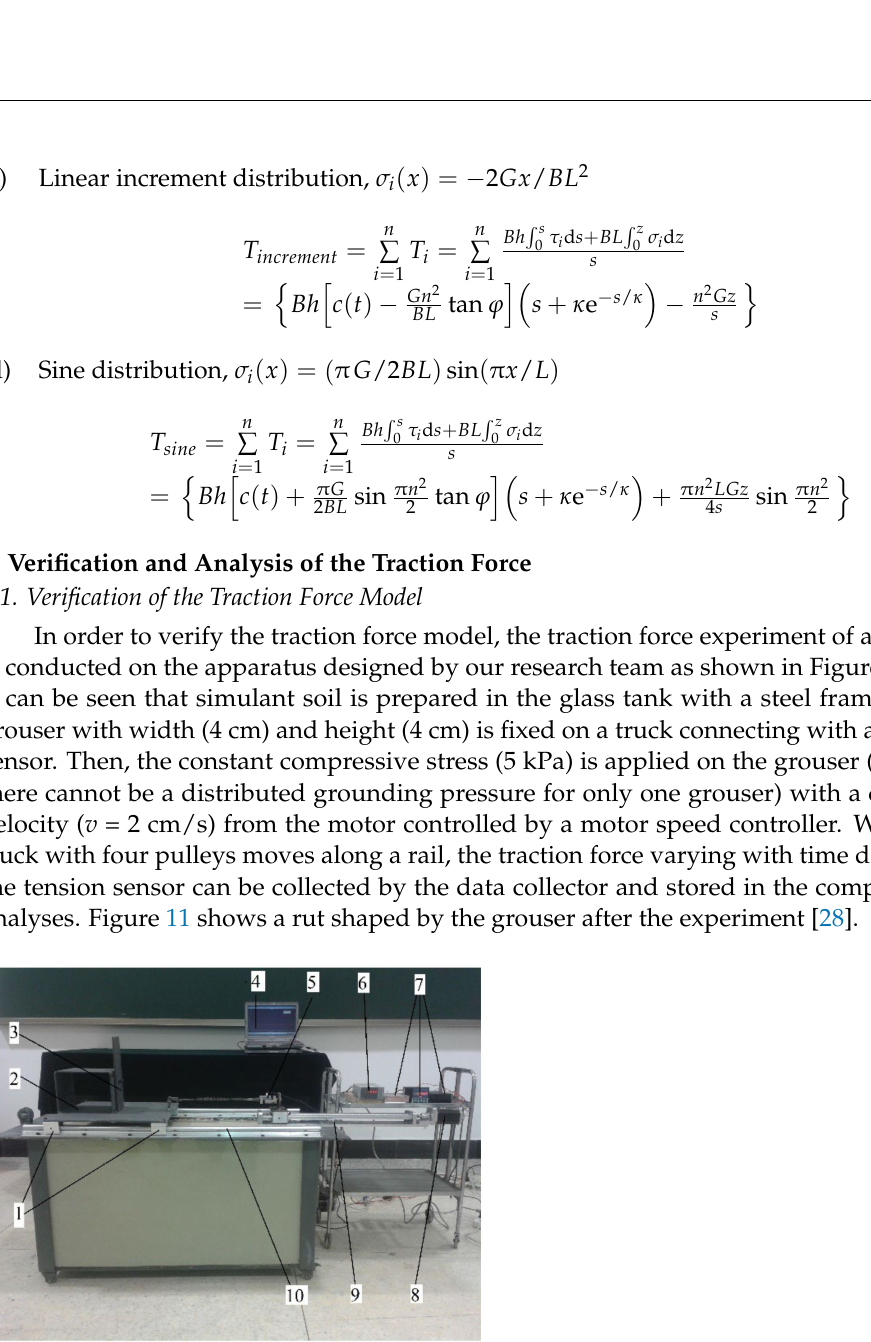
Figure 10. Traction force experiment apparatus of track shoe grouser. 1, Pulley; 2, Truck; 3, Grouser; 4, Computer; 5, NS-WL1 tension sensor; 6, Data collector; 7, Motor speed controller; 8, Motor; 9, Screw rod; 10, Rail.